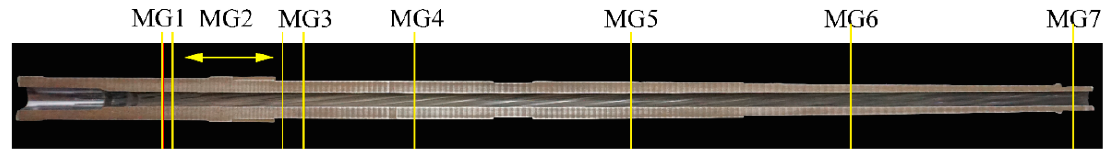
Figure 1. Sample positions in a large-caliber machine gun